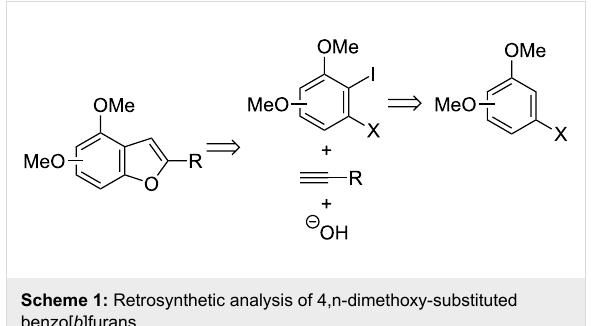
Among the various approaches developed for the synthesis of the benzofuran ring system, the cyclodehydration of α -aryloxy ketones [29], the Claisen rearrangement of an allyl aryl ether followed by Pd-catalyzed intramolecular oxidative cyclization [30], and the tandem Sonogashira coupling/heterocyclization of 2-halophenols with terminal alkynes [31], are some of the most used. However, their application to the synthesis of 4-substi- tuted benzo[ b ]furans is especially challenging, because the meta -substituted starting materials tend to cyclize at the less hindered ortho -position, leading to the formation of 6-substi- tuted heterocycles or a mixture of 6- and 4-substituted ones [32].